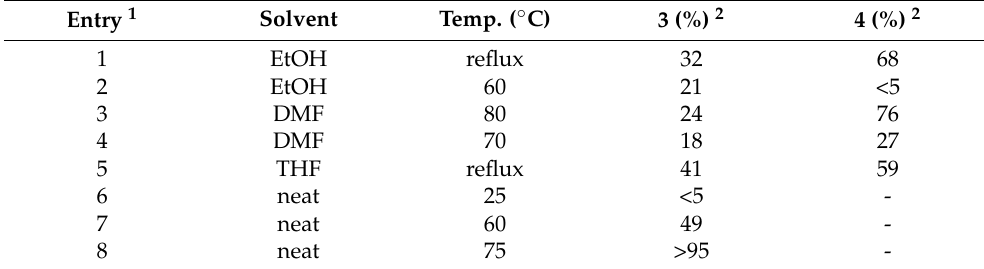
Table 1. Optimization of ammonium salt 3 synthesis.